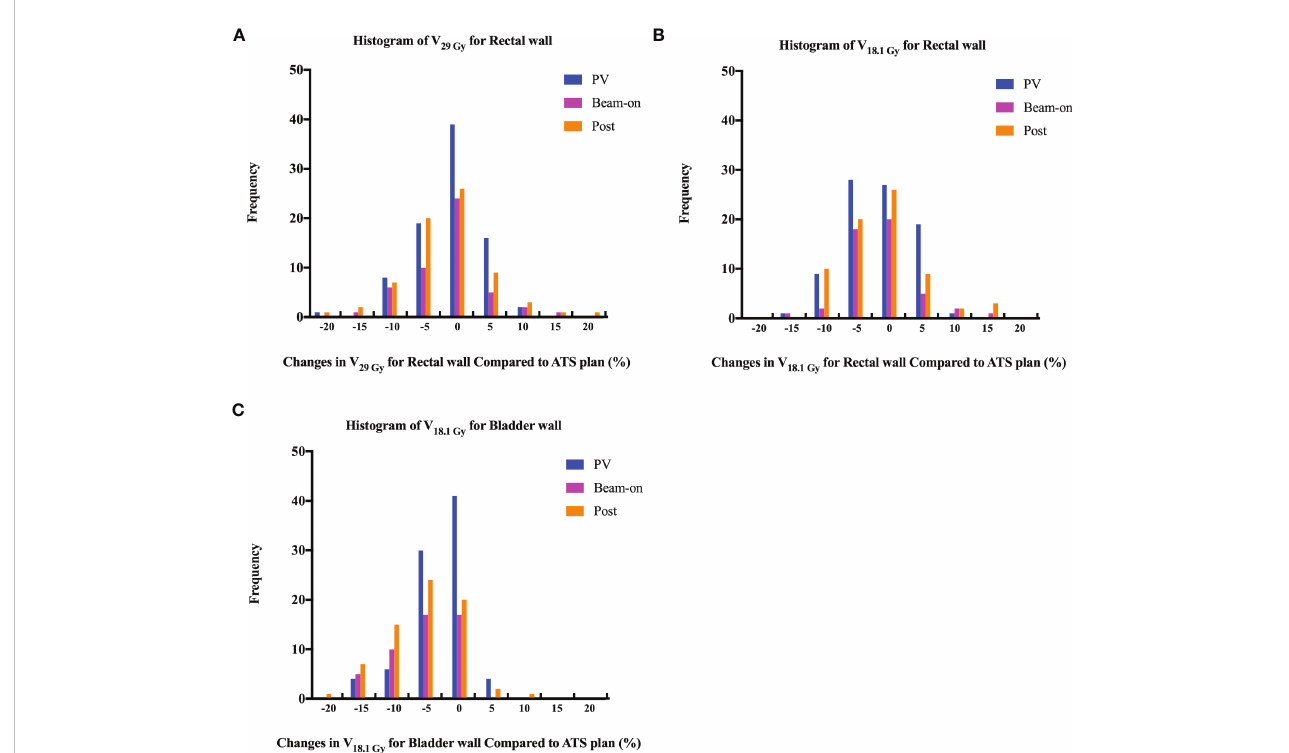
FIGURE 5 Histogram of changes in volume receiving 29 Gy ( A , V 29 Gy ) or 18.1 Gy ( B , V 18.1 Gy ) dose for rectal wall and 18.1 Gy (C) dose (V 18.1 Gy ) for bladder wall among PV-, Bn- and post-MR scans compared to ATS